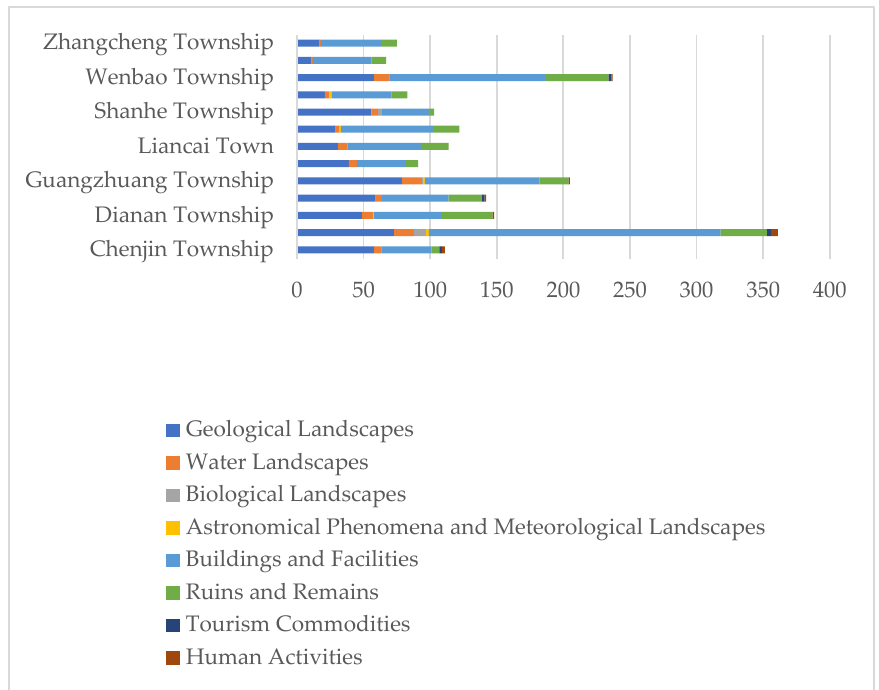
Figure 5. Quantity and structure of tourism resources in each township of Longde County. Table 3. Quantity and variation coefficient of tourism resources in Longde County.